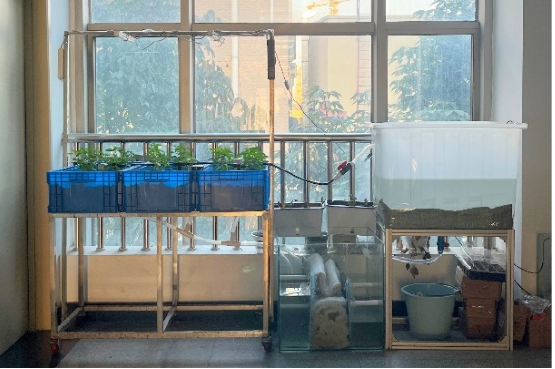
Figure 13. Proposed aquaponics system.